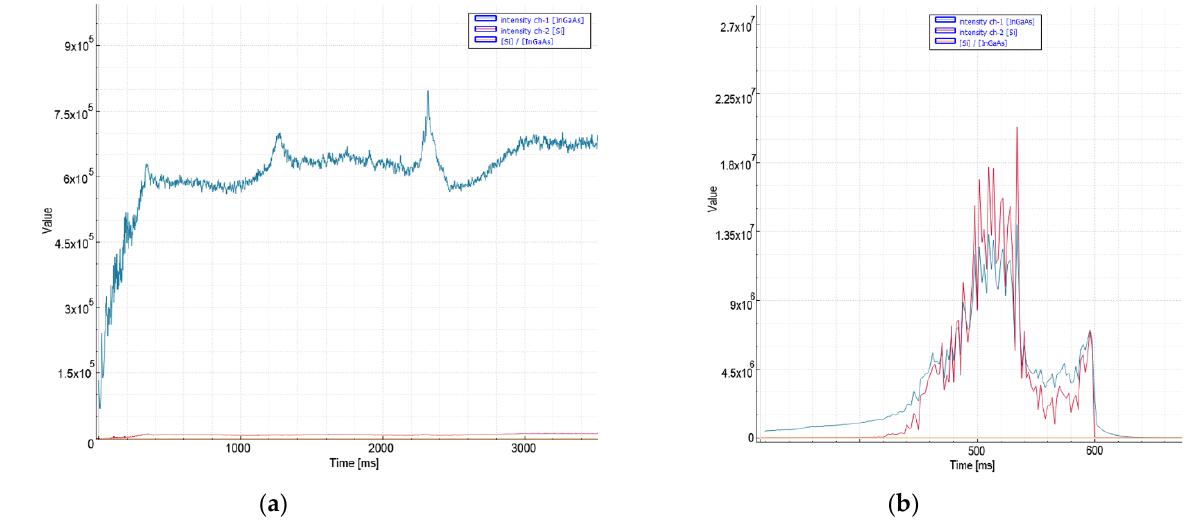
Figure 6. Measurement values recorded during nitrogen cutting of 8 mm stainless steel material: ( a ) quality cut with ideal parameters, ( b ) the moment of deterioration of cut and quality.